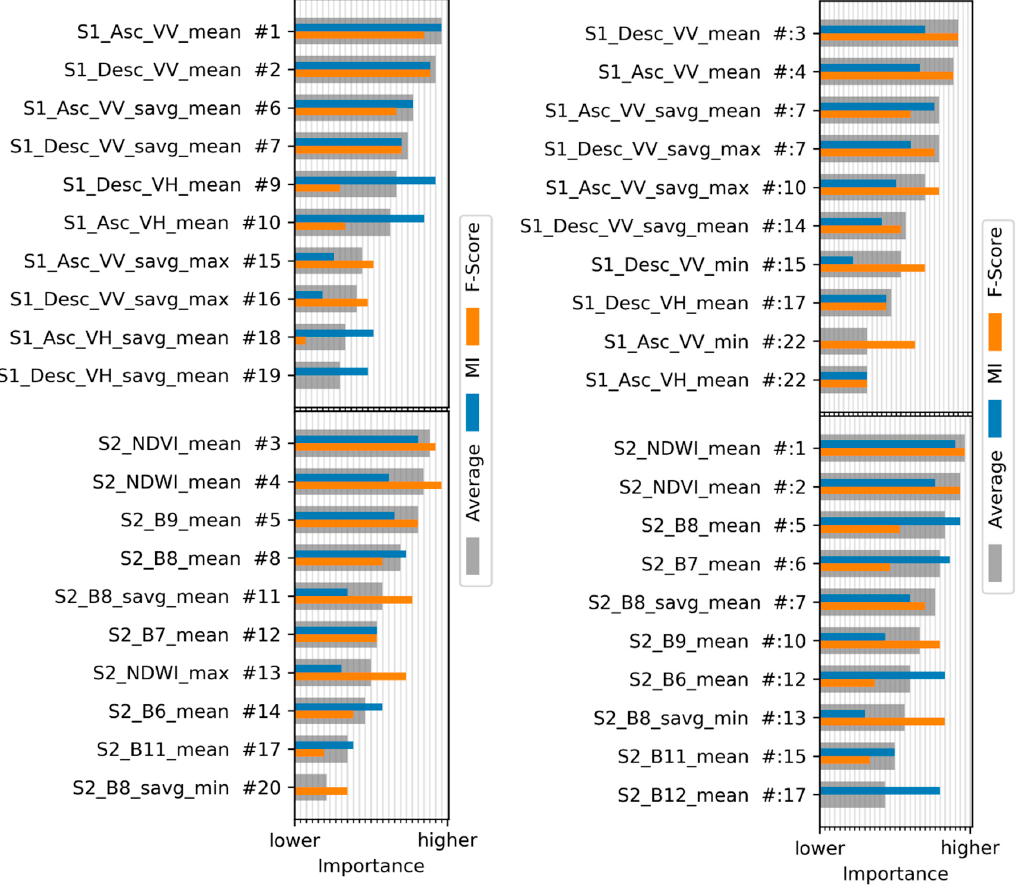
Figure 13. Averaged feature importance ranking grouped by S1 and S2 features (Stockholm left, Beijing right).